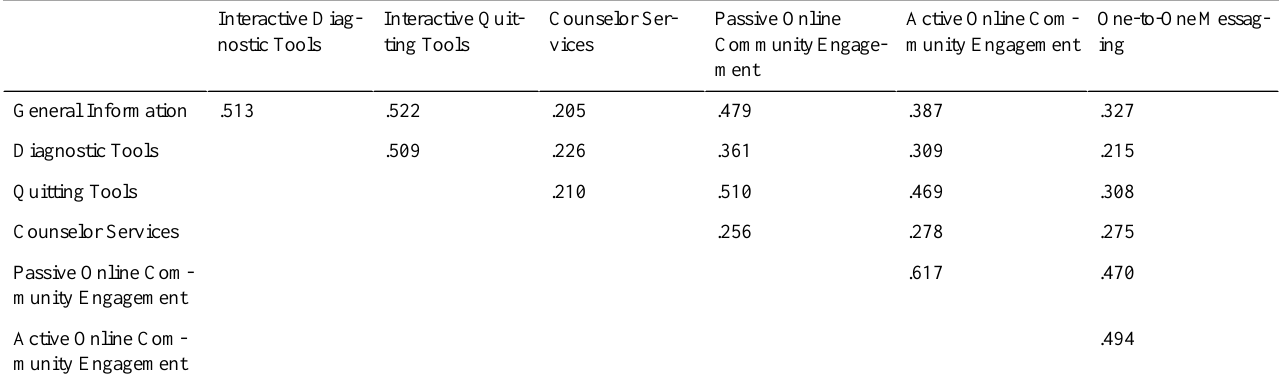
Table 3. Correlation matrix for utilization measures (N = 607) a